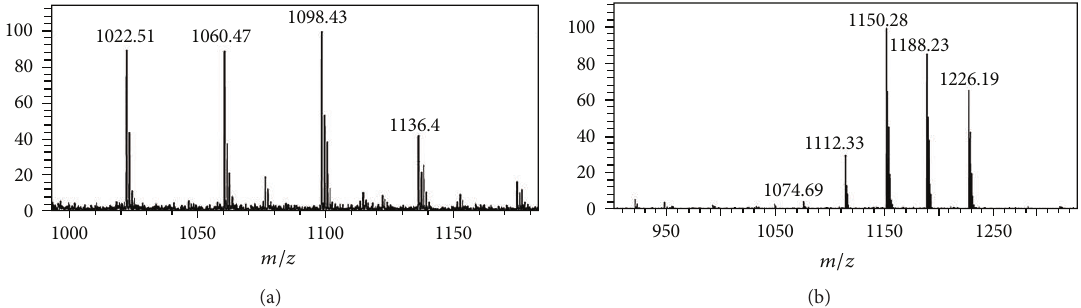
Figure 5: Mass spectral characterization of CoA derivatives of TOFA and C75. HPLC purified TOFYL-CoA (Panel a, 𝑚/𝑧 = 1074.69 ) and C75-CoA (Panel b, 𝑚/𝑧 = 1022.51 ) were examined by matrix-assisted laser desorption ionization time-of-flight (MALDI-TOF) mass spectrometry utilizing a Shimadzu/Kratos Axima CFR MALDI-TOF mass spectrometer (Columbia, MD, USA) in reflectron mode. Samples were analyzed by the dried-drop method using 𝛼 -4-hydroxycinnamic acid (Sigma-Aldrich) as the matrix. The instrument was calibrated with angiotensin (𝑚/𝑧 = 1046.5) and fibrinopeptide B (𝑚/𝑧 = 1570.7) . The calibrants were obtained from Sigma-Aldrich. The parent ions for TOFyl-CoA and C75-CoA were obtained at 𝑚/𝑧 = 1022.51 (a) and 𝑚/𝑧 = 1074.69 (b),